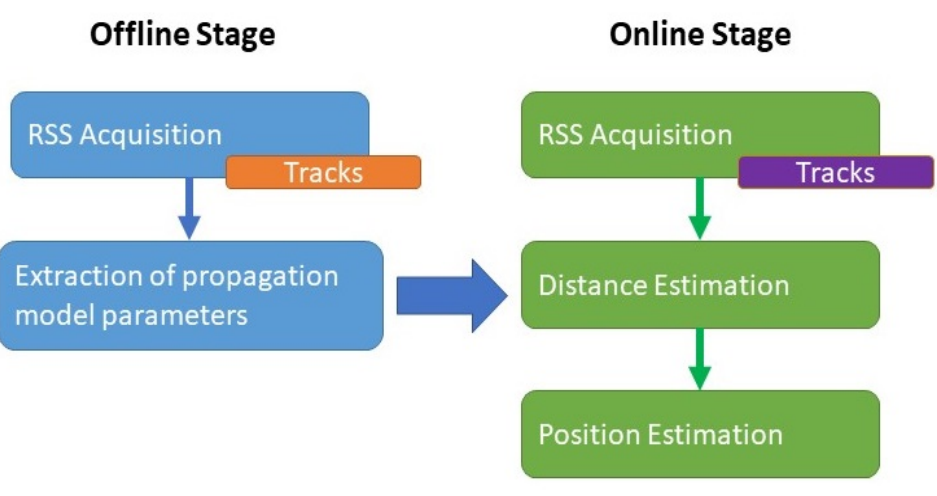
Figure 6. Block diagram of the offline and online stages.